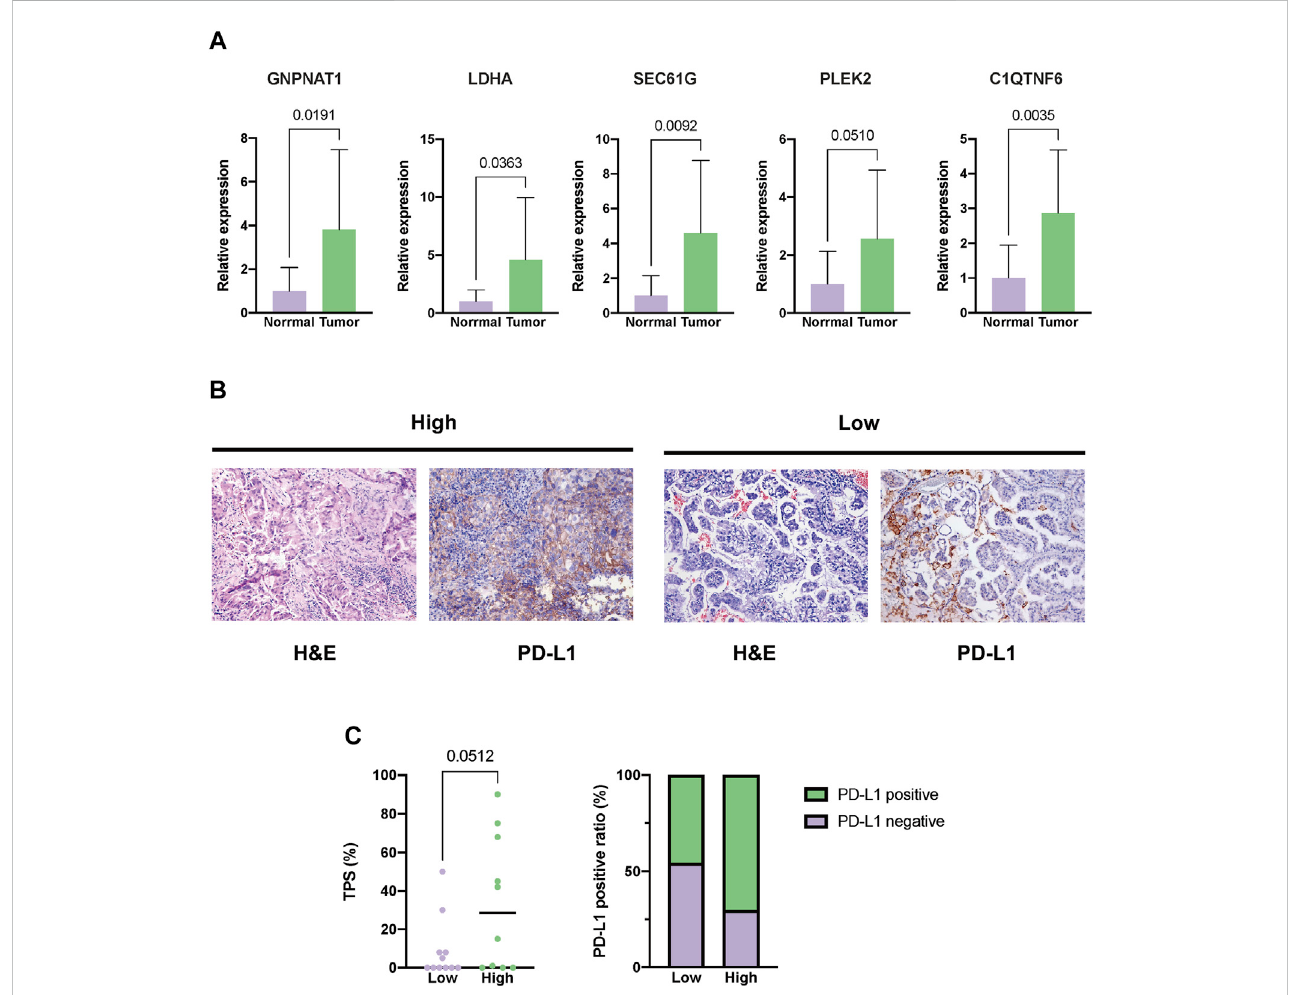
FIGURE 12 External validation in our local cohorts. (A) Evaluating the expression difference between tumor ( n = 21) and normal tissues ( n = 11) using real-time polymerase chain reaction (PCR). (B) Representative imagesof PD-L1 staining of tumor tissues from the high- or low-risk LUAD patients. (C) Differencein the expression level between the high- ( n = 10) and low-risk groups ( n = 11). The expression level of PD-L1 was depicted as the tumor proportion score